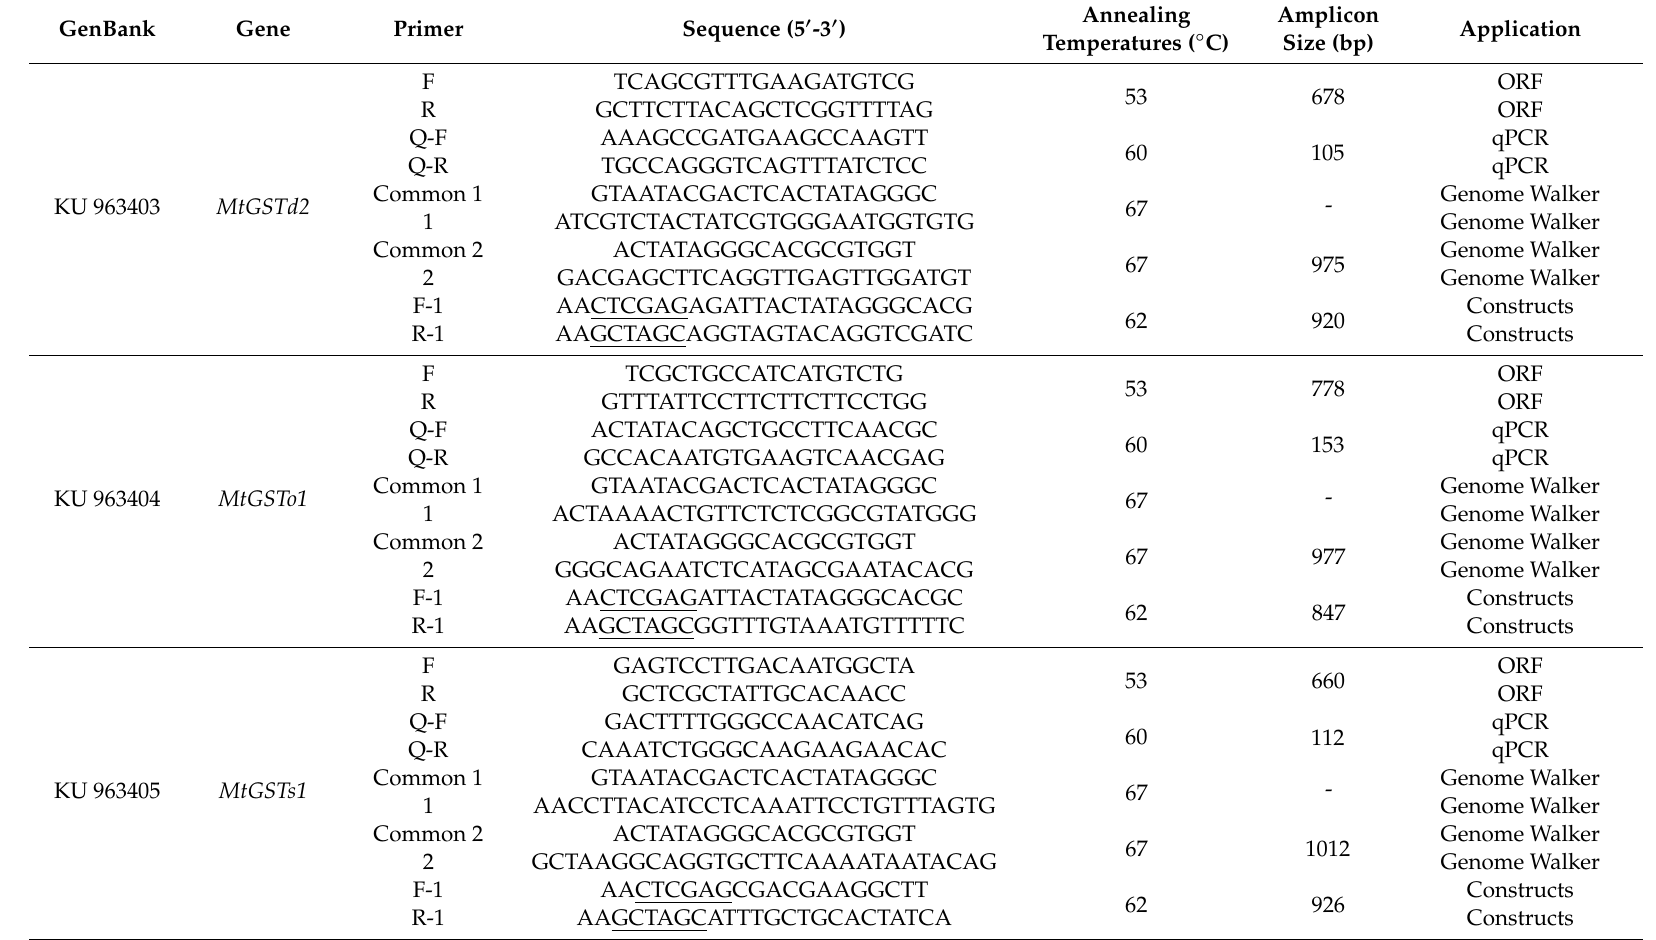
Table 1. Primers used in